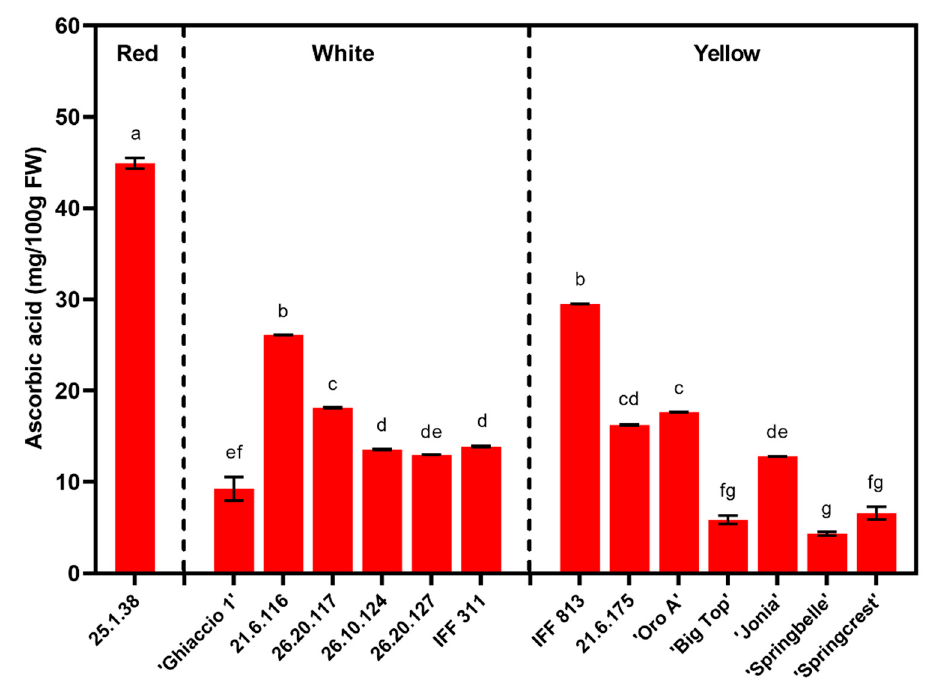
Figure 3. Ascorbic acid at harvest in 2007 for all commercial cultivars and breeding accessions divided by flesh color. Tukey (HSD) test for post-hoc mean comparisons. Columns with the same letter above indicate non-significance at p < 0.05. Means ± S.E. displayed.